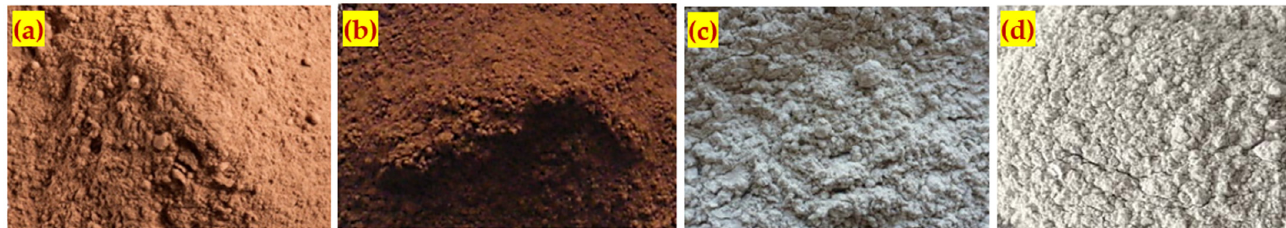
Figure 1 . Sourced materials: ( a ) NL; ( b ) RM; ( c ) BFS; ( d ) LPW. Figure 1. Sourced materials: ( a ) NL; ( b ) RM; ( c ) BFS; ( d ) LPW.